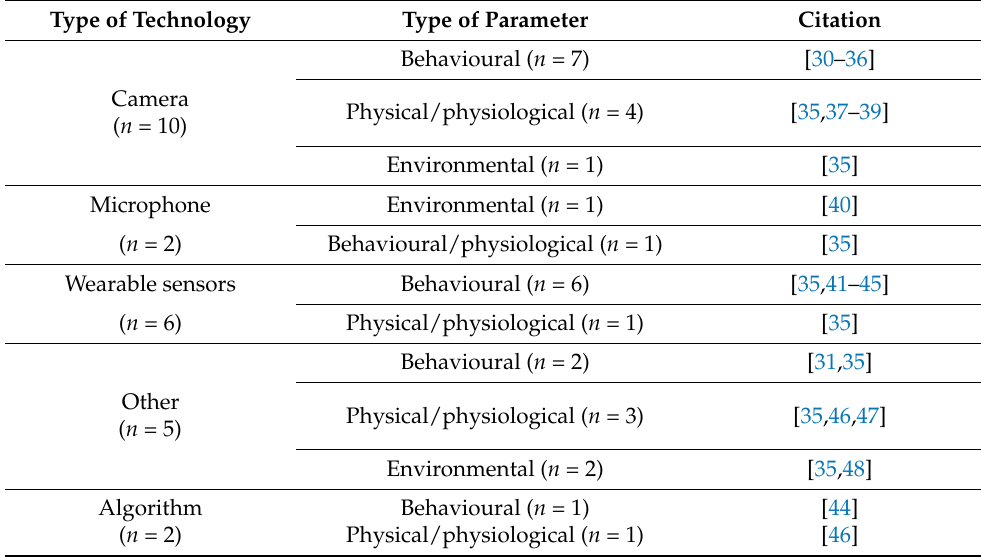
Table 4. Number of publications by type of technology used for the study and type of parameter investigated. Publications can have more than one technology used and parameter